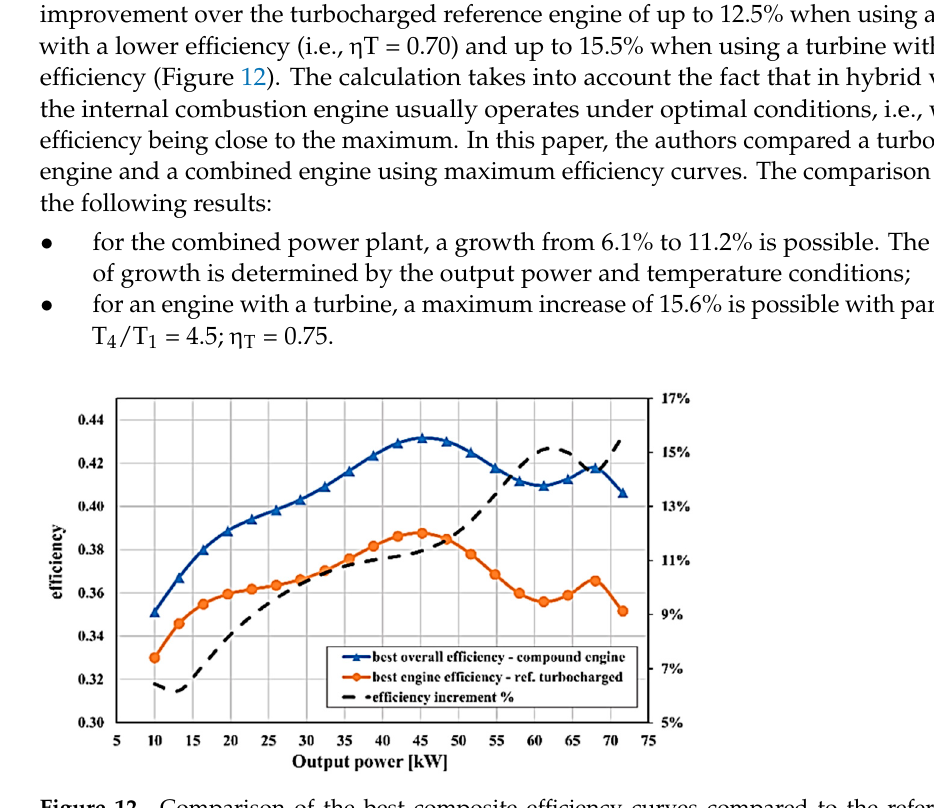
Figure 12. Comparison of the best composite efficiency curves compared to the reference turbocharged engine.